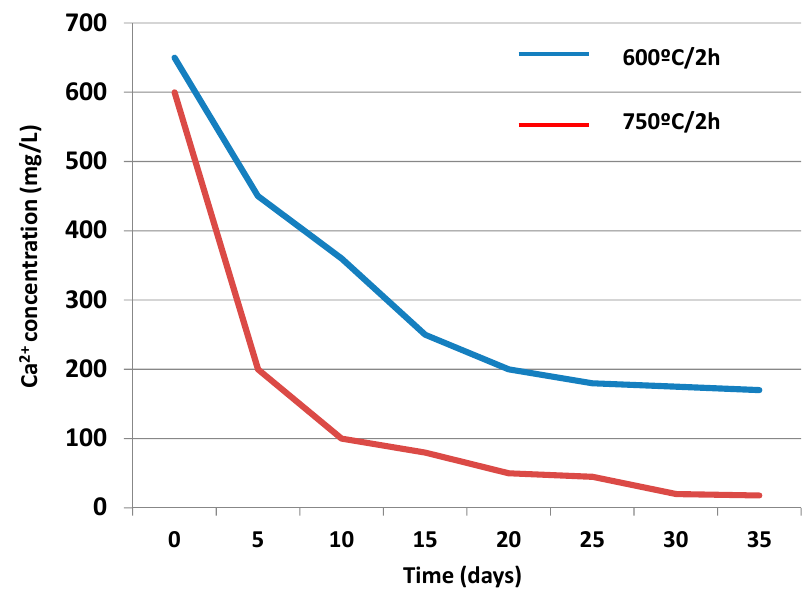
Figure 7. Behavior of Ca 2 + concentration in the thermally activated kaolin systems.